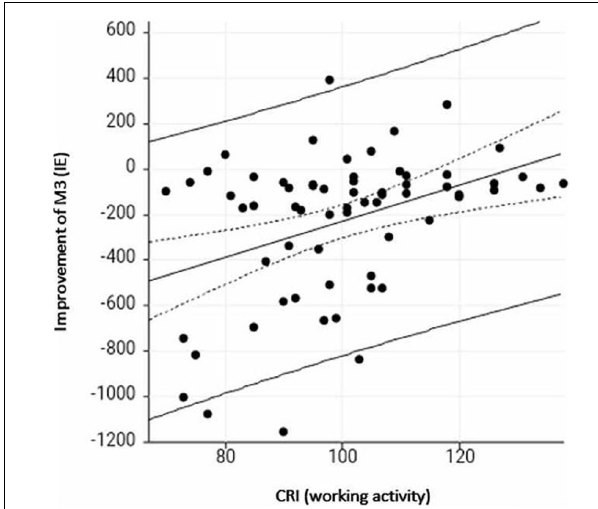
FIGURE 2 | Scatterplot of CRI working activity and improvement in the attentional task (inverse efficiency) from pre- to 24 months post implantation. A lower score on the y-axis (M3 test) indicates greater improvement, a higher score on the x-axis (CRI-working activity) indicates a higher cognitive reserve index (CRI).